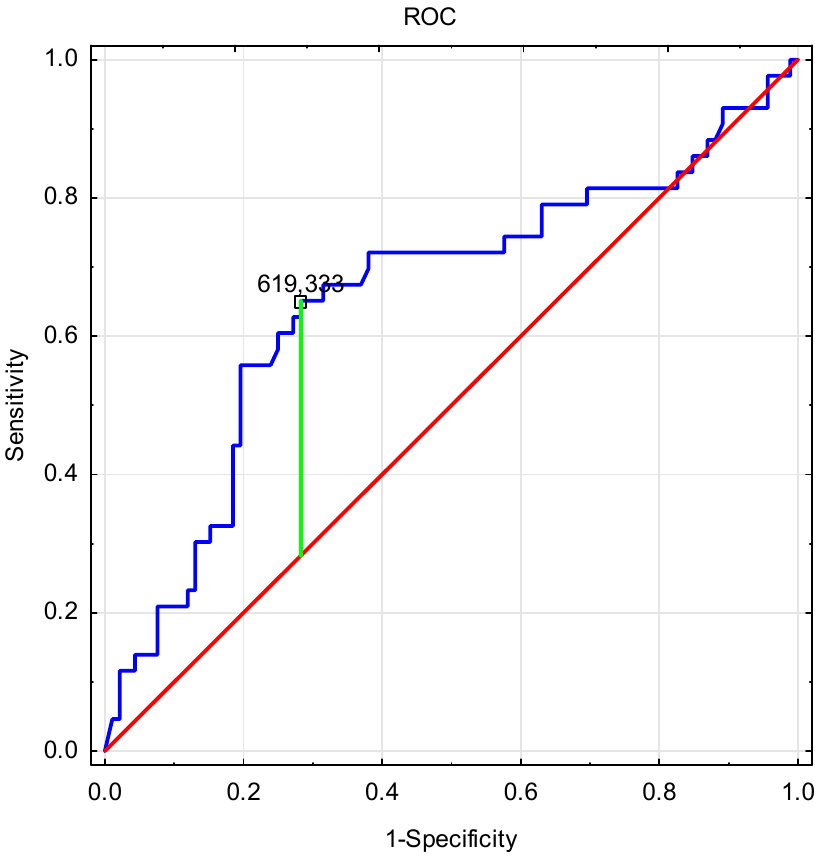
Figure 1. Receiver Operating Characteristic Curve (ROC) curve for PINP with regard to TDS.